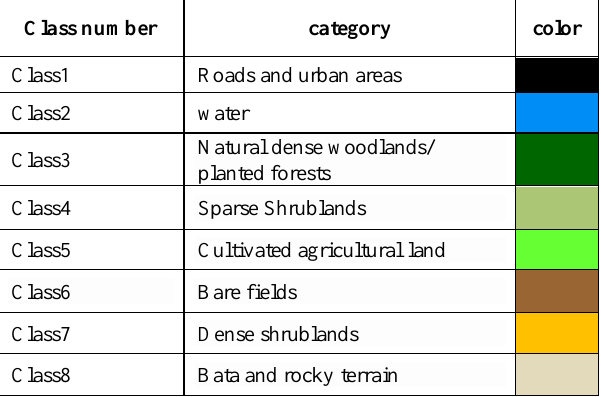
Table 2 : Description of interpretation categories